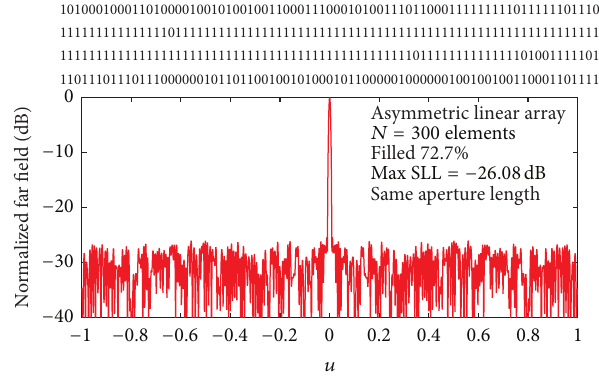
Figure 8: Radiation pattern of the best obtained array for the 300- element asymmetric thinned array with same aperture length.